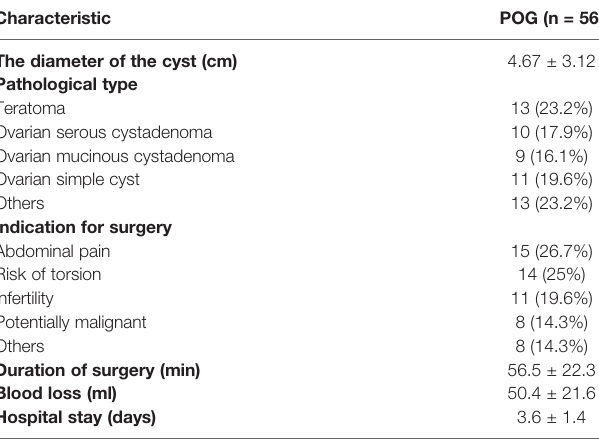
TABLE 2 | Baseline clinical characteristics of